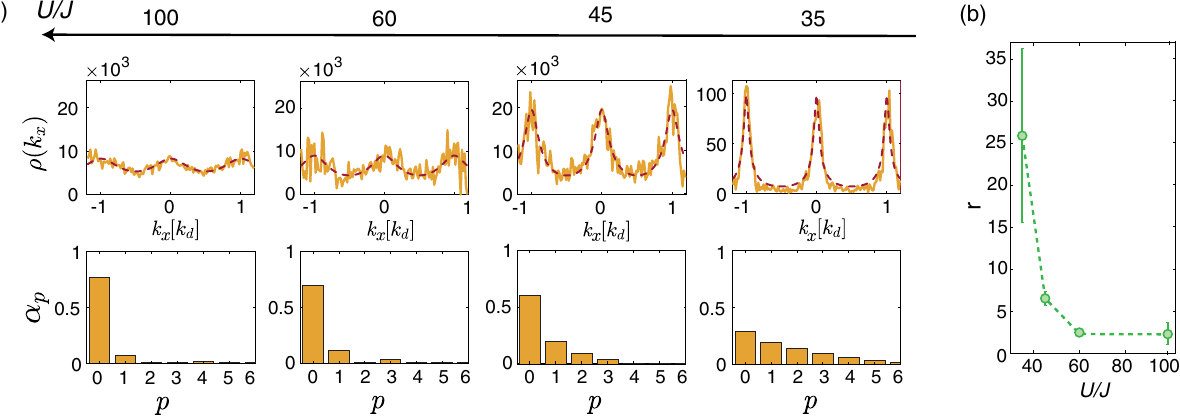
∝ Z ð k − 1 in x Þ x Þ (cid:2) = c